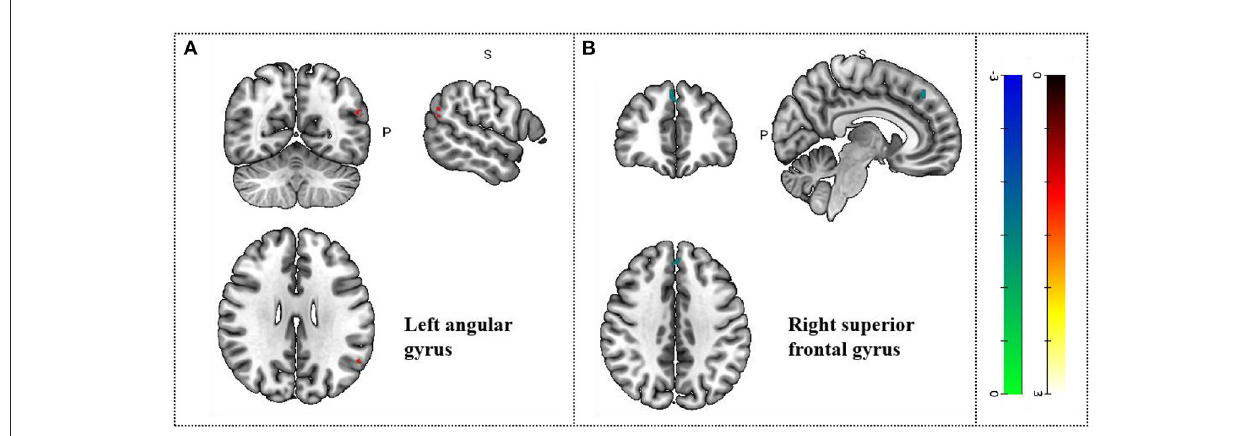
FIGURE3 Changes in gray matter regions PRE and POST acupuncture treatment in MCI patients. (A) Left angular gyrus. (B) Right superior frontal gyrus. Important clusters are presented with MRIcron